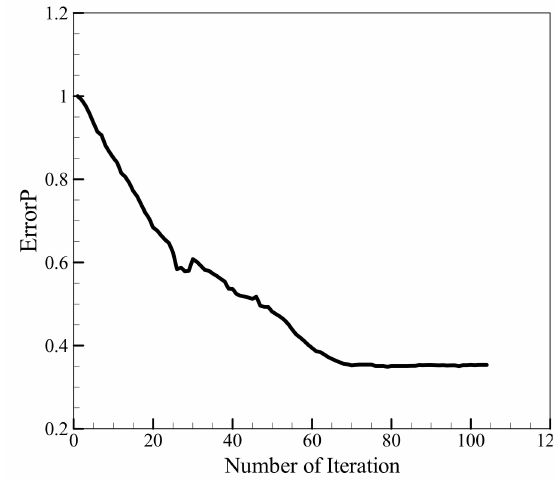
Figure 17. Variations of the residual of pressure differences for the second design case by the UESA, with applying the spine constraint and E